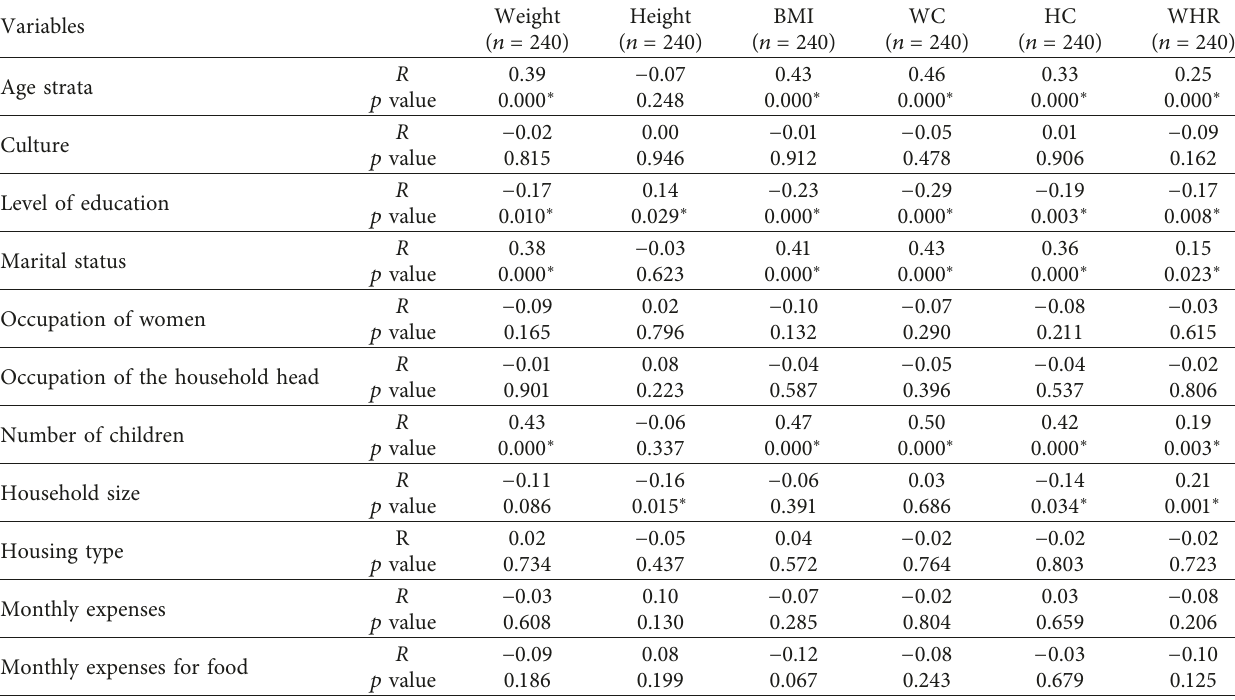
Table 4: Association between anthropometric measures and socioeconomic status in studied women.